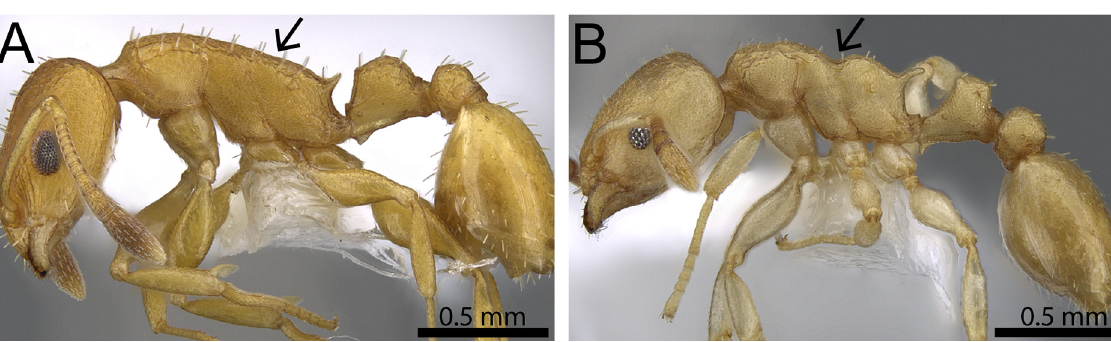
Fig. 8. Body in profile. A . Nesomyrmex angulatus (Mayr, 1862) (CASENT0922010). B . N. stramineus (Arnold, 1948) (CASENT0922011).